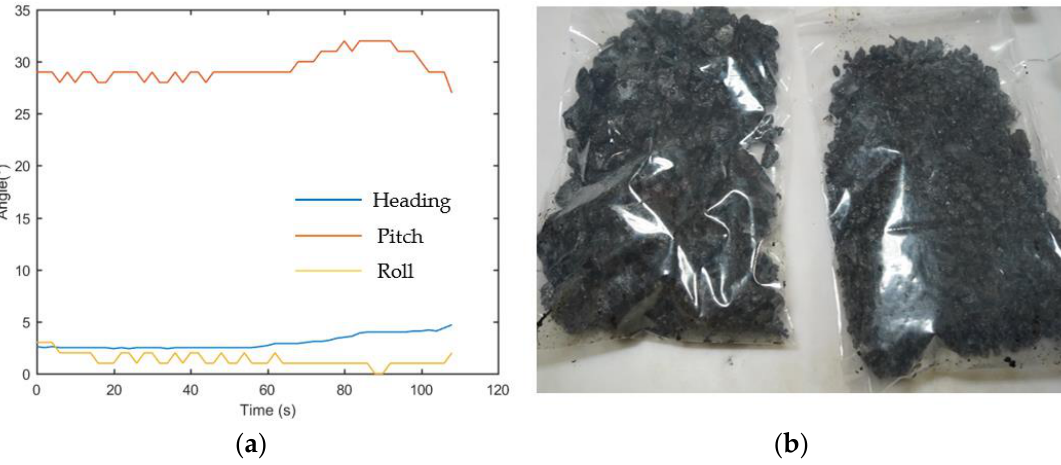
Figure 16. The attitude and heading angle of vehicle ( a ); particles collected by this cutting test ( b ).